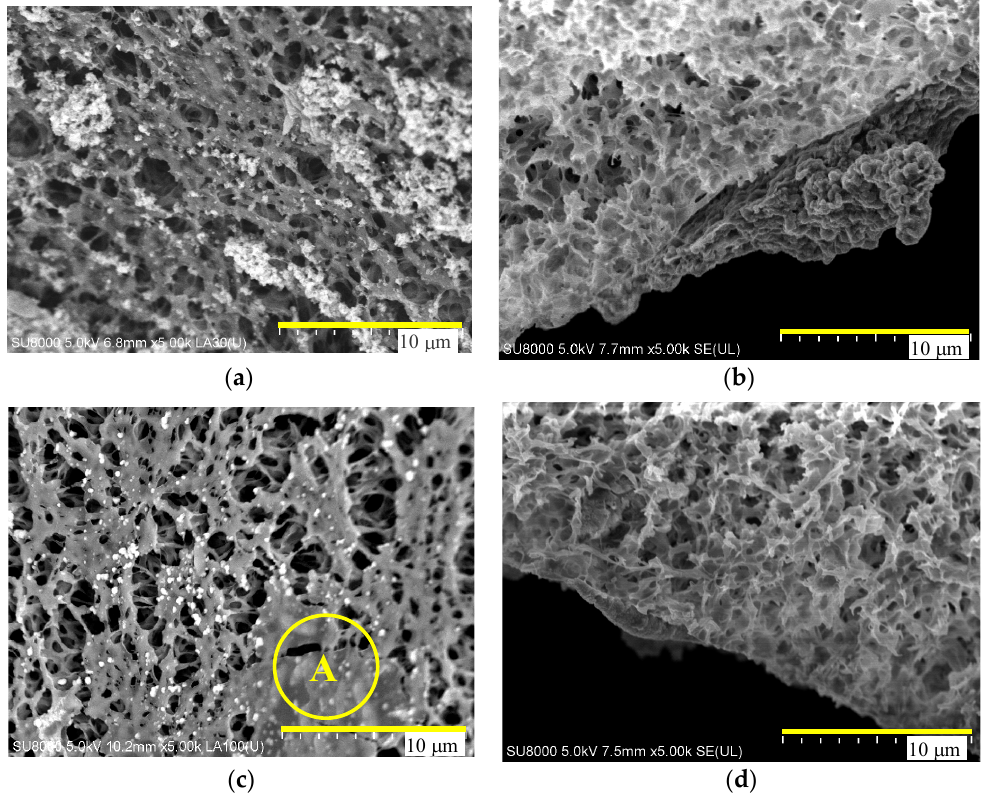
Figure 15. SEM images of membranes with deposit formed during separation of lake water by MD. Membranes Accurel PP S6/2. ( a ) Module MK1, T F = 333 K; ( b ) cross ‐ sections of membrane sample from module MK1; ( c ) module MK1B, T F = 313 K; and ( d ) cross ‐ sections of membrane sample from module MK1B.